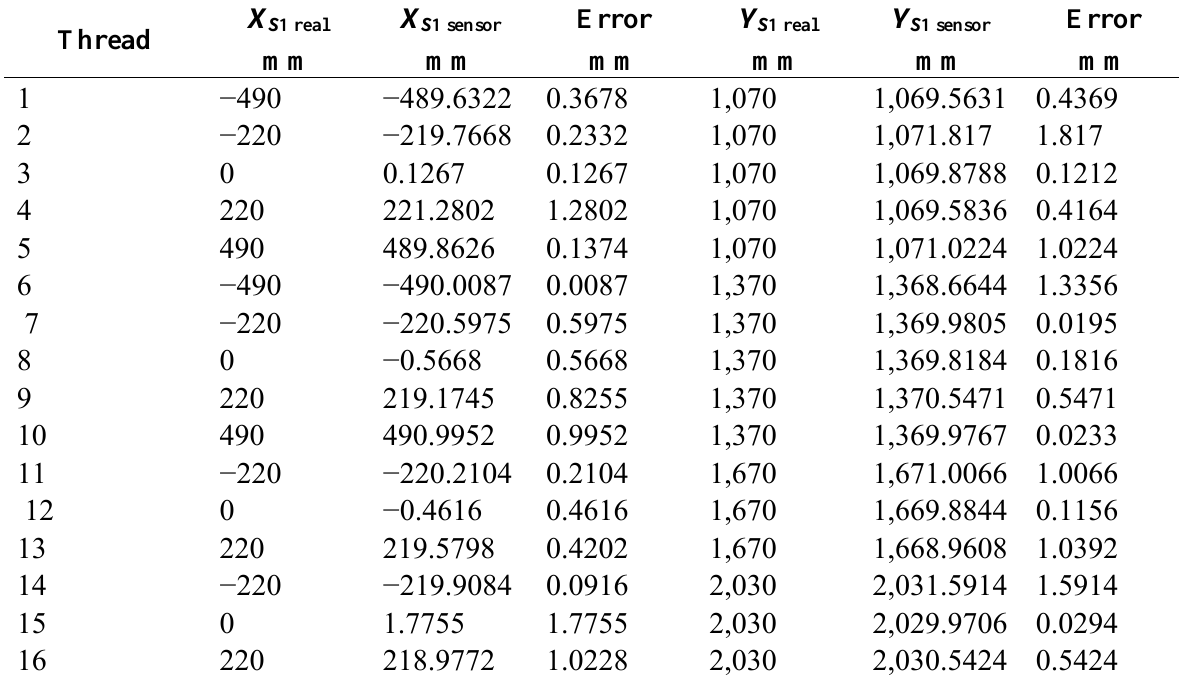
Table 2. Real and sensor measured coordinates for different points